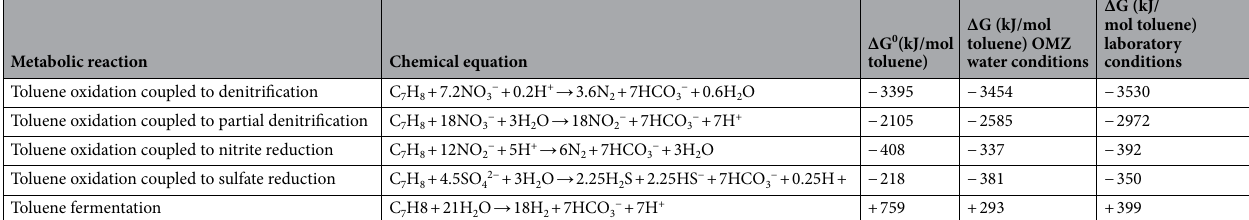
Table 1. Anaerobic toluene degradation reactions in laboratory incubations of suboxic waters collected in January 18, 2011 at Station 18 off Concepción at 65 m depth in the OMZ. Gibbs energy (ΔG) was calculated assuming substrate and product activities, temperature, and pH of the suboxic water column conditions for austral spring at the sampling site as well as for the conditions of incubations. For comparison, Standard Gibbs energy (ΔG 0 ) values are shown.